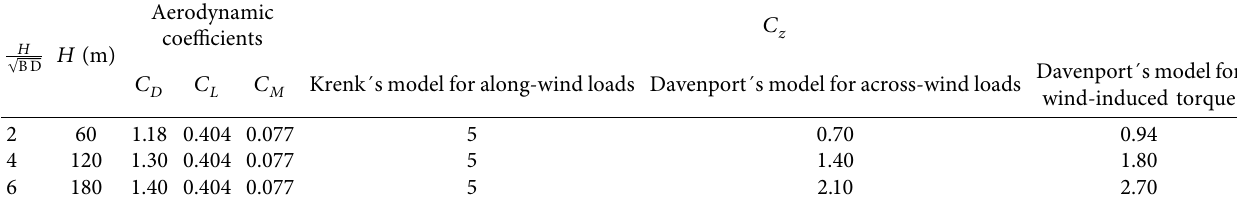
Table 5: Aerodynamics coefficients and vertical decay constants for the wind loads: D / B � 1.